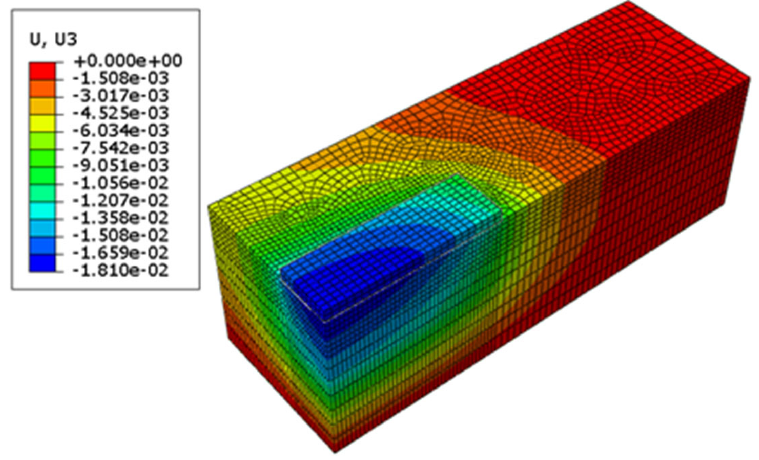
Figure 9. Vertical settlement contour of raft slab foundation of 9# building (m). The settlement at the corner points and midpoint of the raft boundary line were extracted and compared with the above. From Figure 10, it can be seen that the simulated settlement by the finite element method (FEM) is also close to the measured value, and the bending stiffness of the raft slab is considered in the FEM.